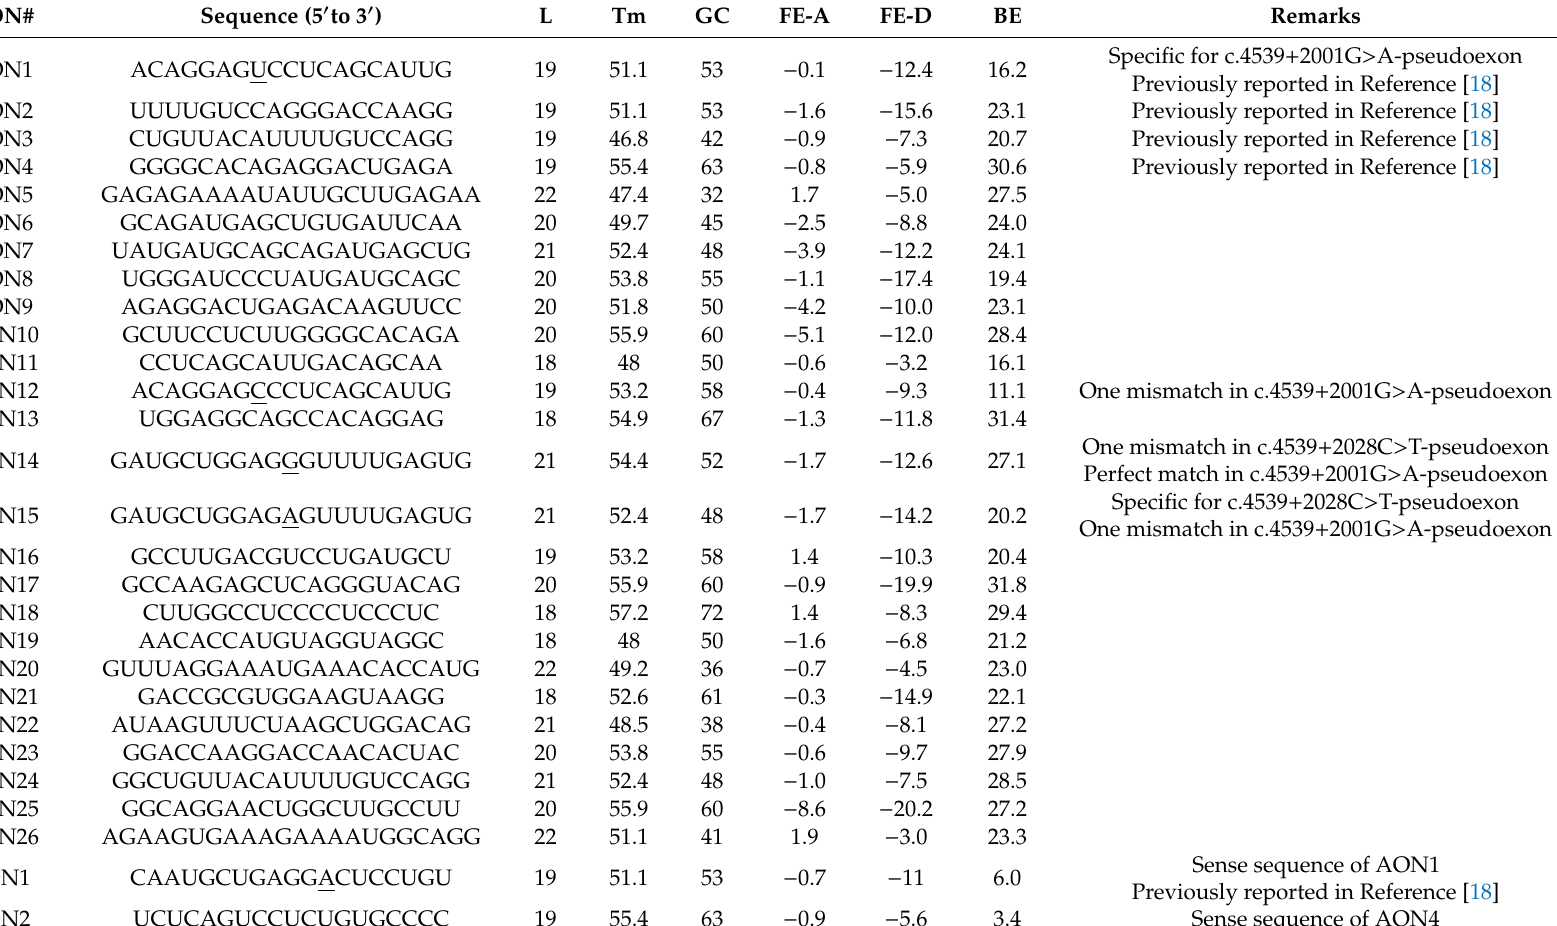
Table 1. Antisense oligonucleotide (AON) sequences and general